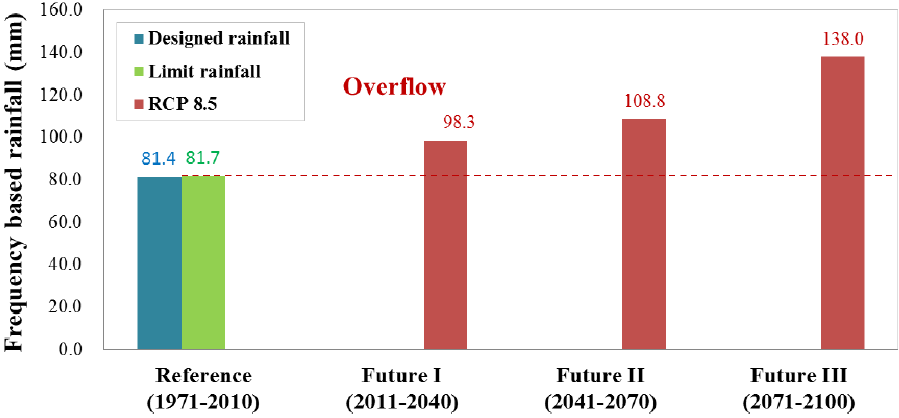
Figure 7. Comparison between design rainfall and frequency-based rainfall.